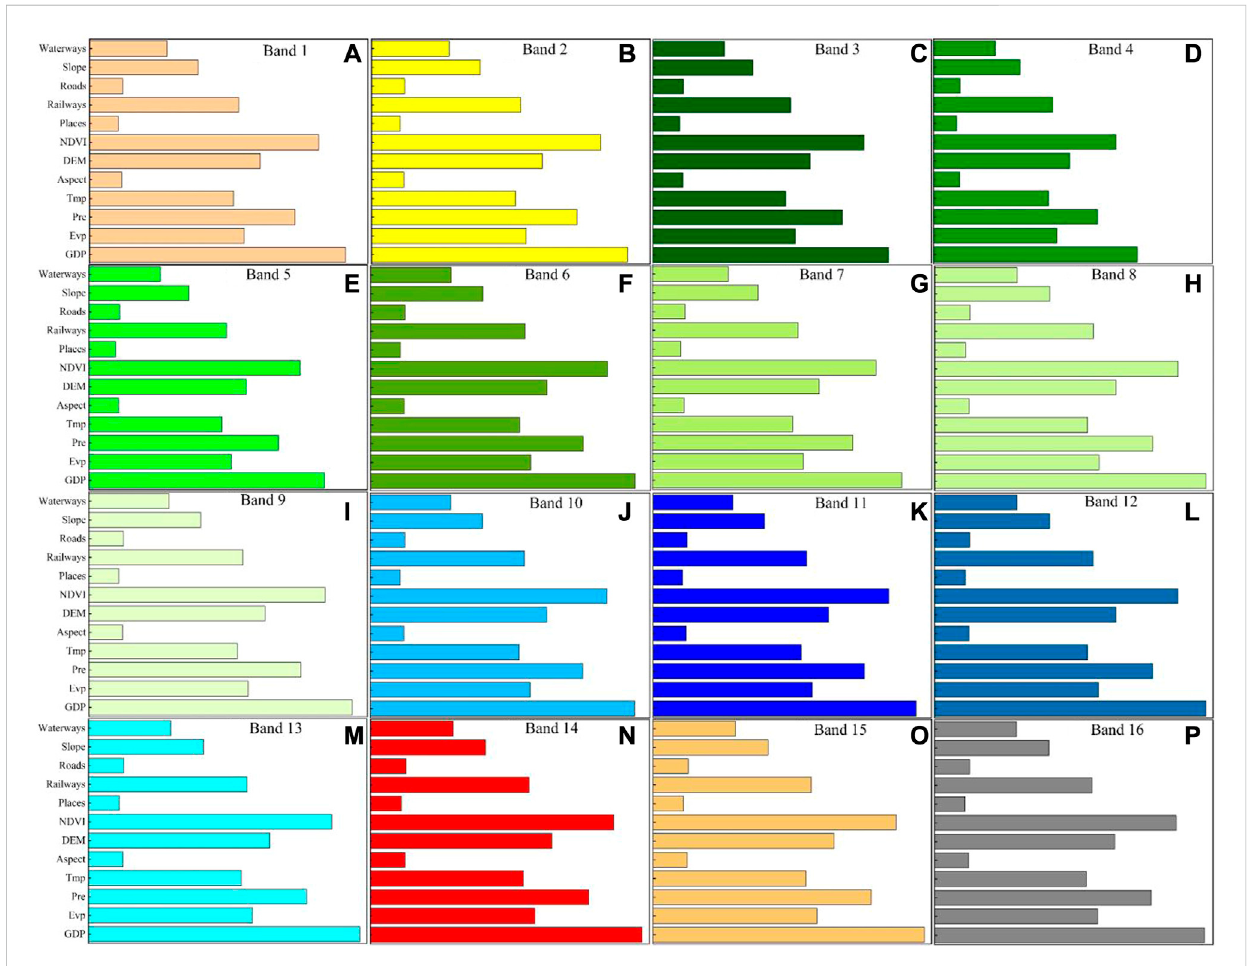
FIGURE 11 Weighting of the importance of different drivers affecting land use change. (A) Land use Band 1 Contribution, (B) Land use Band 2 Contribution, (C) LanduseBand3Contribution, (D) LanduseBand4Contribution, (E) LanduseBand5Contribution, (F) LanduseBand6Contribution, (G) LanduseBand7 Contribution, (H) Land use Band 8 Contribution, (I) Land use Band 9 Contribution, (J) Land use Band 10 Contribution, (K) Land use Band 11 Contribution, (L) Land use Band 12 Contribution, (M) Land use Band 13 Contribution, (N) Land use Band 14 Contribution, (O) Land use Band 15 Contribution, (P) Land use Band 16